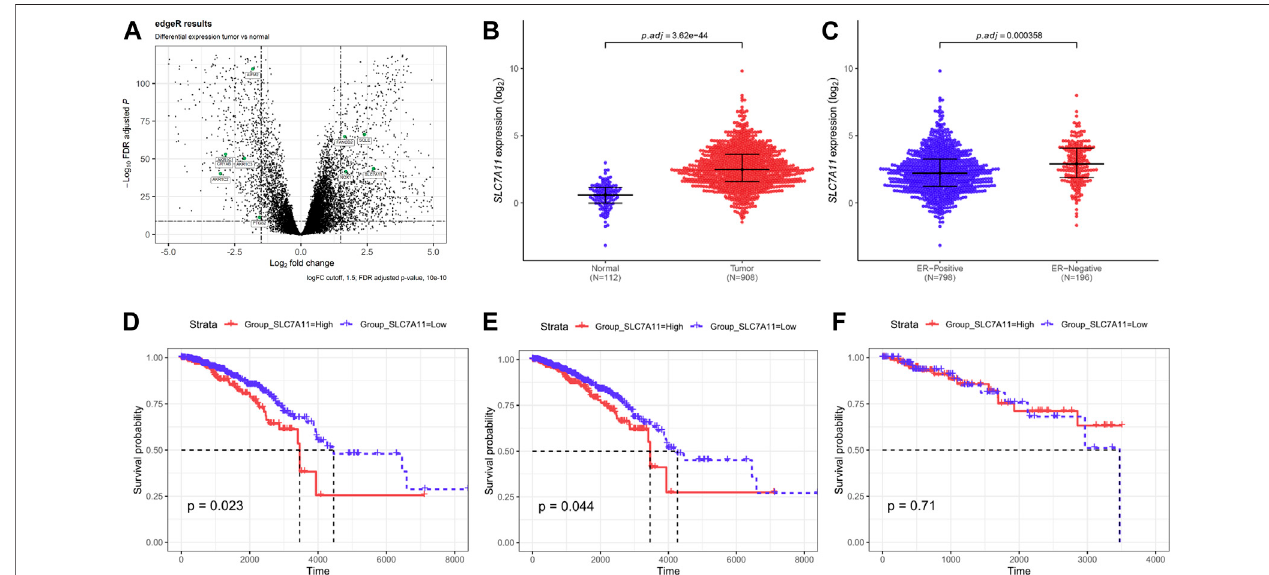
FIGURE 1 | Compared with normal tissues, ferroptosis-related gene SLC7A11 was upregulated in breast cancer tissues and contributed to poor survival. (A) The differentiallyexpressedgenes(DEGs)wereidenti fi edbetweenTPandNTwithinbreastcancerpatients.Volcanoplotshowsthegenestatisticalsigni fi cancewith|log2FC| > 1.5 and FDR < 10 -10 . The green points were ferroptosis-related genes. (B,C) Comparison of SLC7A11 expression in different subgroups. Normal and tumor (B) ; ER- positive and ER-negative (C) . ( D – F ) Kaplan – Meier curves of overall survival (OS) in breast cancer according to SLC7A11 expression. Overall survival analysis (D) ; Subgroup analyses of OS in ER-positive (E) and ER-negative (F)